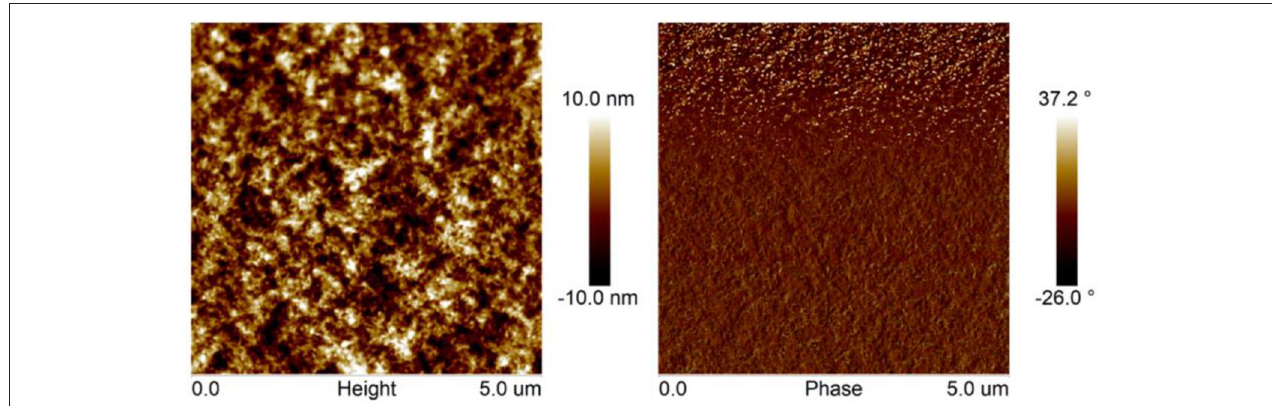
FIGURE 4 | AFM height and phase images of PBDB-T-2Cl: FTr-3PDI-Se blend films.